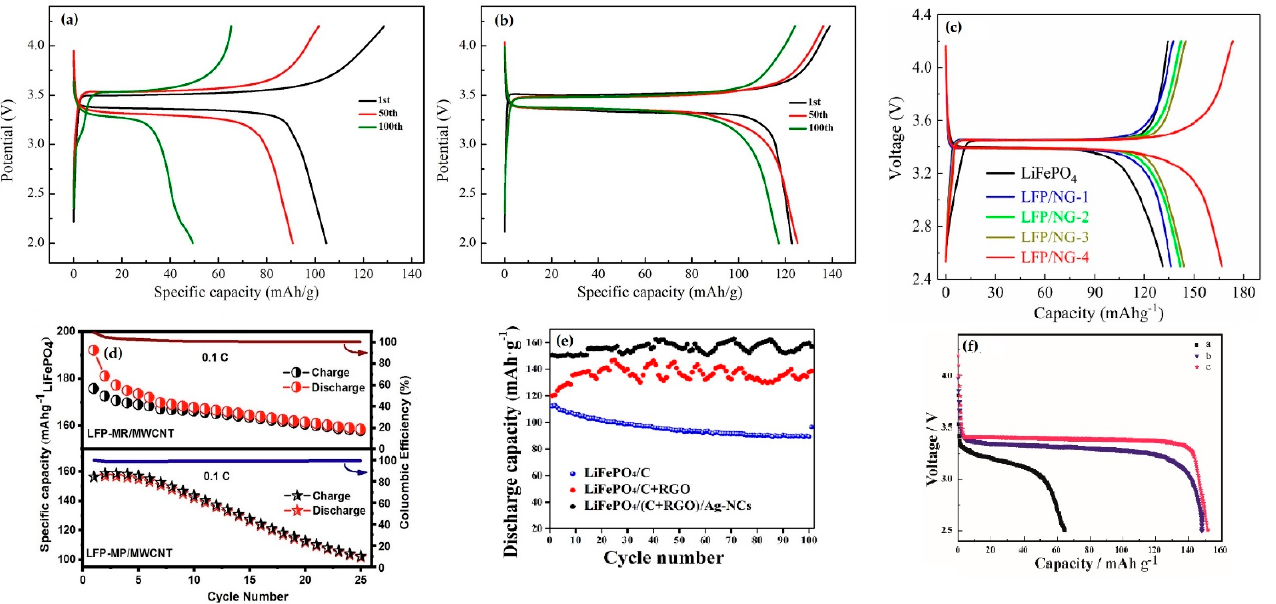
Figure 6. Discharge/charge profiles for different cycle numbers of LiFePO 4 ( a ) and LiFePO 4 -PEG ( b ) [58]. First charge/discharge curves of LiFePO 4 with different N-doping values ( c ) [59]. Dis- charge/charge curves of LiFePO 4 -microrods/MWCNTs ( up ) and LiFePO 4 -microparticles/MWCNTs ( down ) ( d ) [60]. Specific capacity profiles during charge/discharge of LiFePO 4 /C, LiFePO 4 /C + RGO, LiFePO 4 /(C + RGO)/Ag-NCs at 0.2 C rate for 100 cycle numbers ( e ) [62]. First discharge/charge profiles of LiFePO 4 with blocky–a, rod-shaped–b and rod-shaped–c morphology. The first one was grown at 160 °C, while the other two were at 220 and 250 °C, respectively ( f ) [42]. Adapted with permission from Ref [58]. 2021, Springer Nature; Ref [59]. 2021, Elsevier; Ref [60]. 2021, Elsevier and Ref [62]. 2013, Springer Nature.